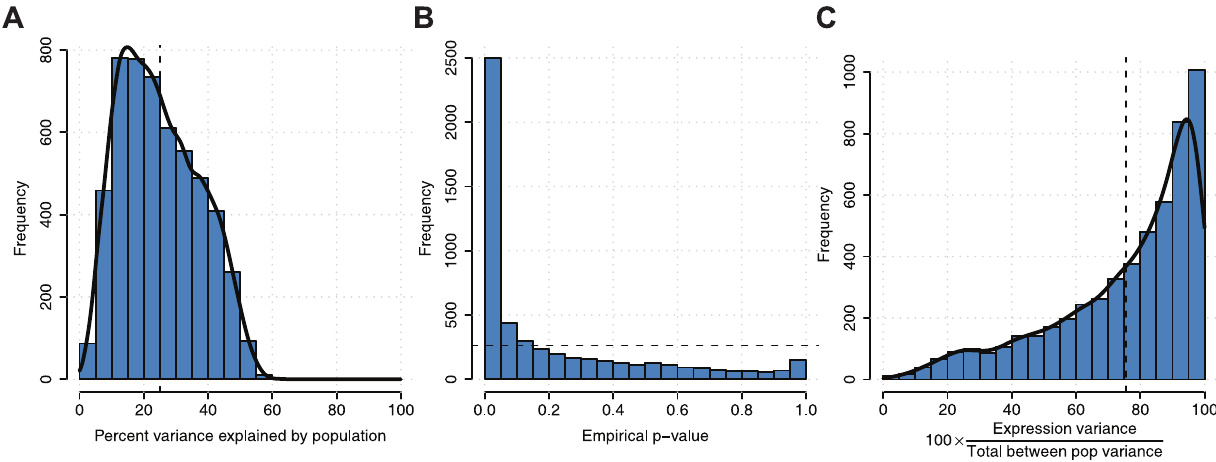
Figure 5. Analysis of variation in gene expression and splicing among individuals attributable to population labels. A) Distribution of percent variance explained by population across n=5,334 expressed genes with $ 2 transcripts expressed across all individuals. B) Empirical p-values for genes in part A. P-values were calculated by permuting population labels for individuals 100 times and comparing to true population labels. Dashed line indicates the uniform p-value distribution expected under the null hypothesis of no association between population label and expression. The output from the multiplicative model can be interpreted similarly to an R 2 coefficient of a linear model. C) The contribution of gene expression in the variance explained by the